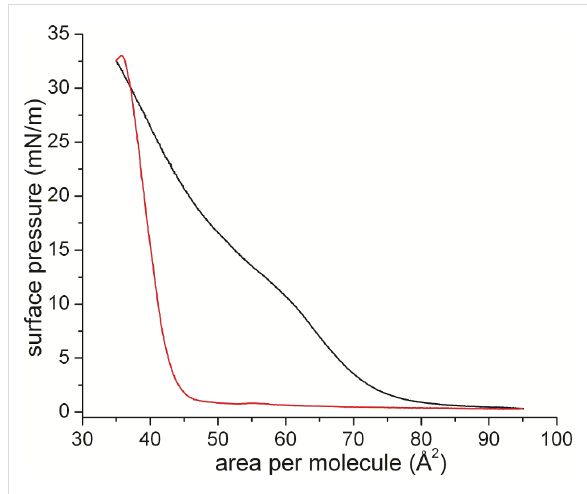
Figure 2: Langmuir–Pockels isotherm of a monolayer of flipper mechanophores during the first compression (black) and subsequent expansion (red) at the air/water interface at 20 °C subphase tempera- ture and 22 °C air